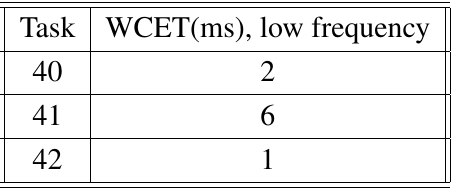
Table 2. Marks sequence on the CPU between times instants 40 and